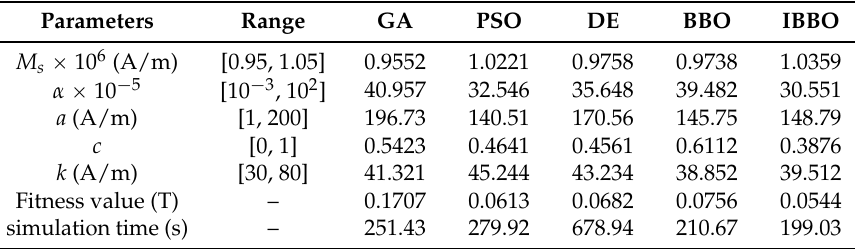
Table 3. Identification results of permolloy.